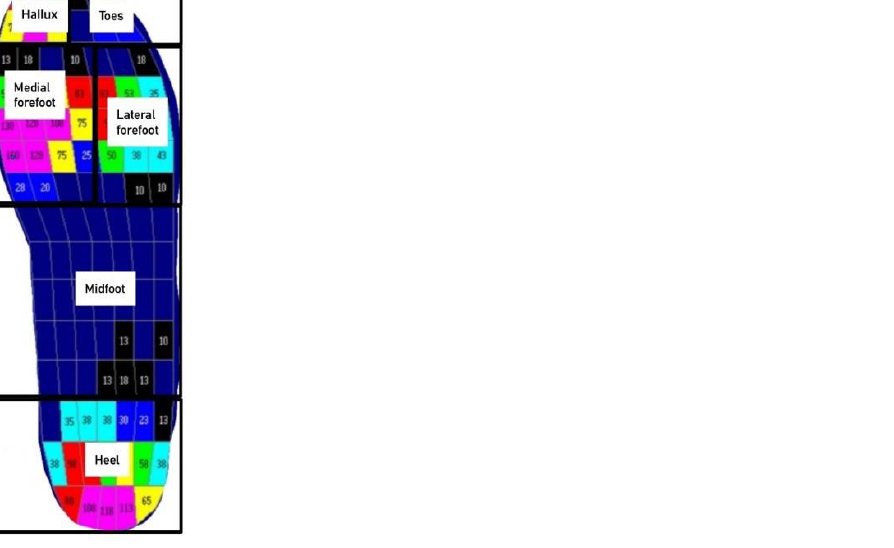
Figure 4. The six parts of the Pedar in-shoe pressure measurement system measurement.